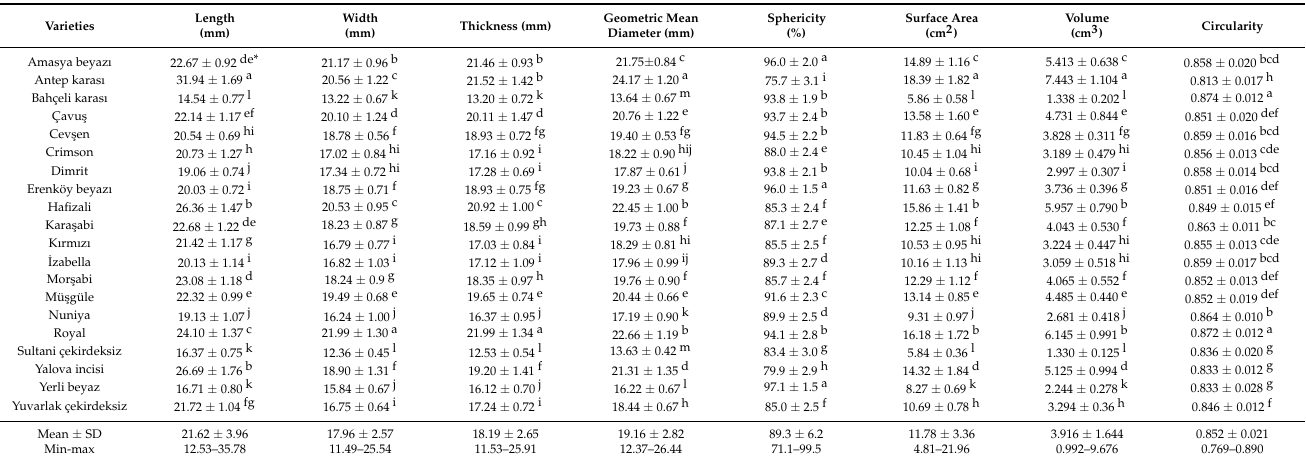
Table 4. Basic morphology and dimensional attributes of the grape